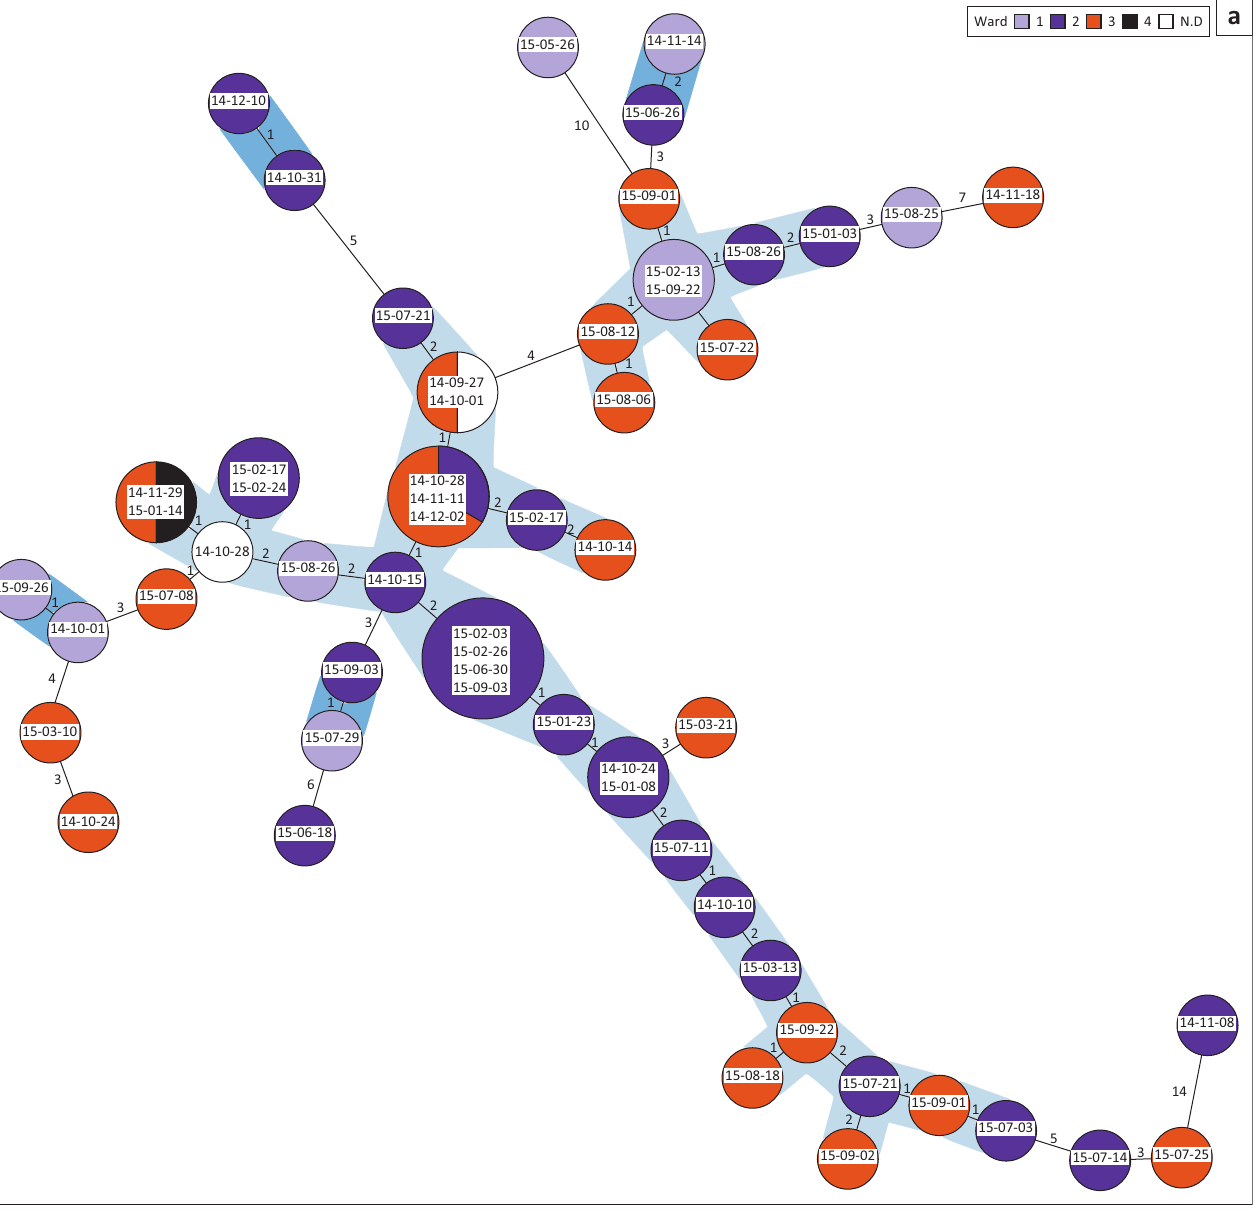
Figure 3 continues on the next page